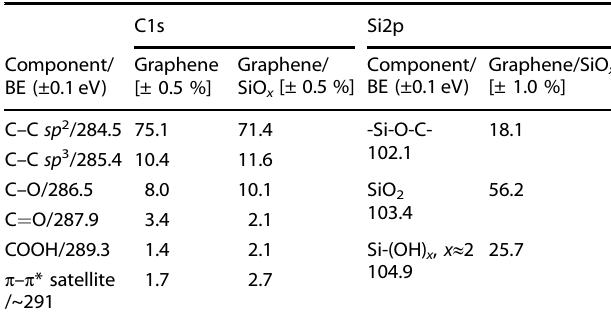
Table 1. Relative (%) atomic concentration of C and Si